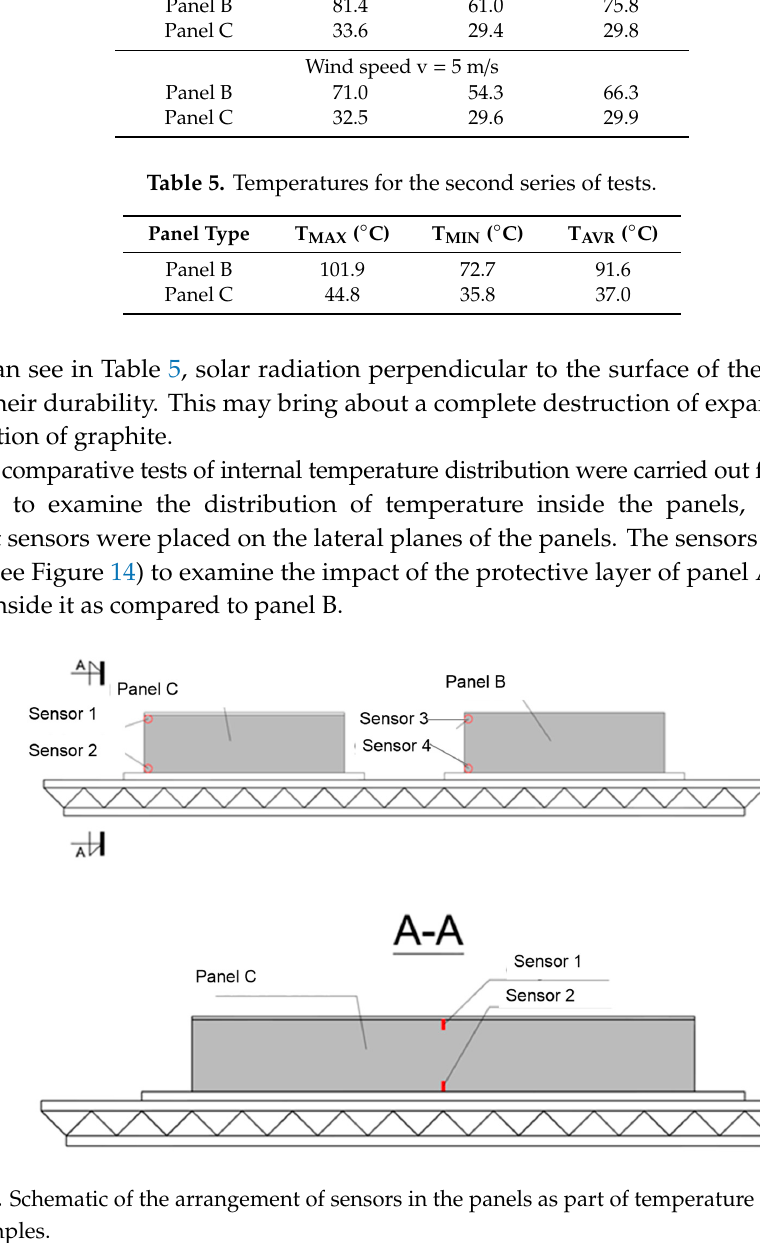
Table 4. Temperatures as the function of wind speed changes read in the measurement fields of the thermogram made for the laboratory stand. Radiation intensity ls = 1008 W / m 2 .